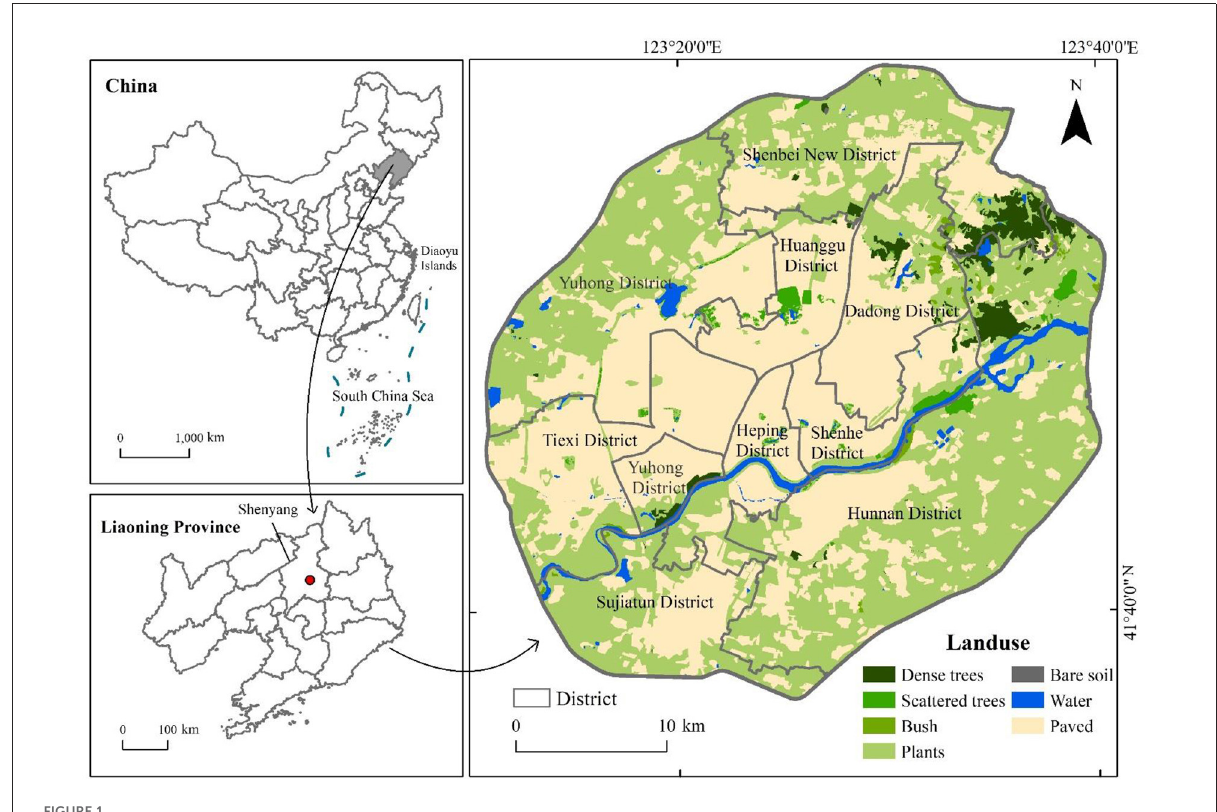
FIGURE1 Location of the study area.